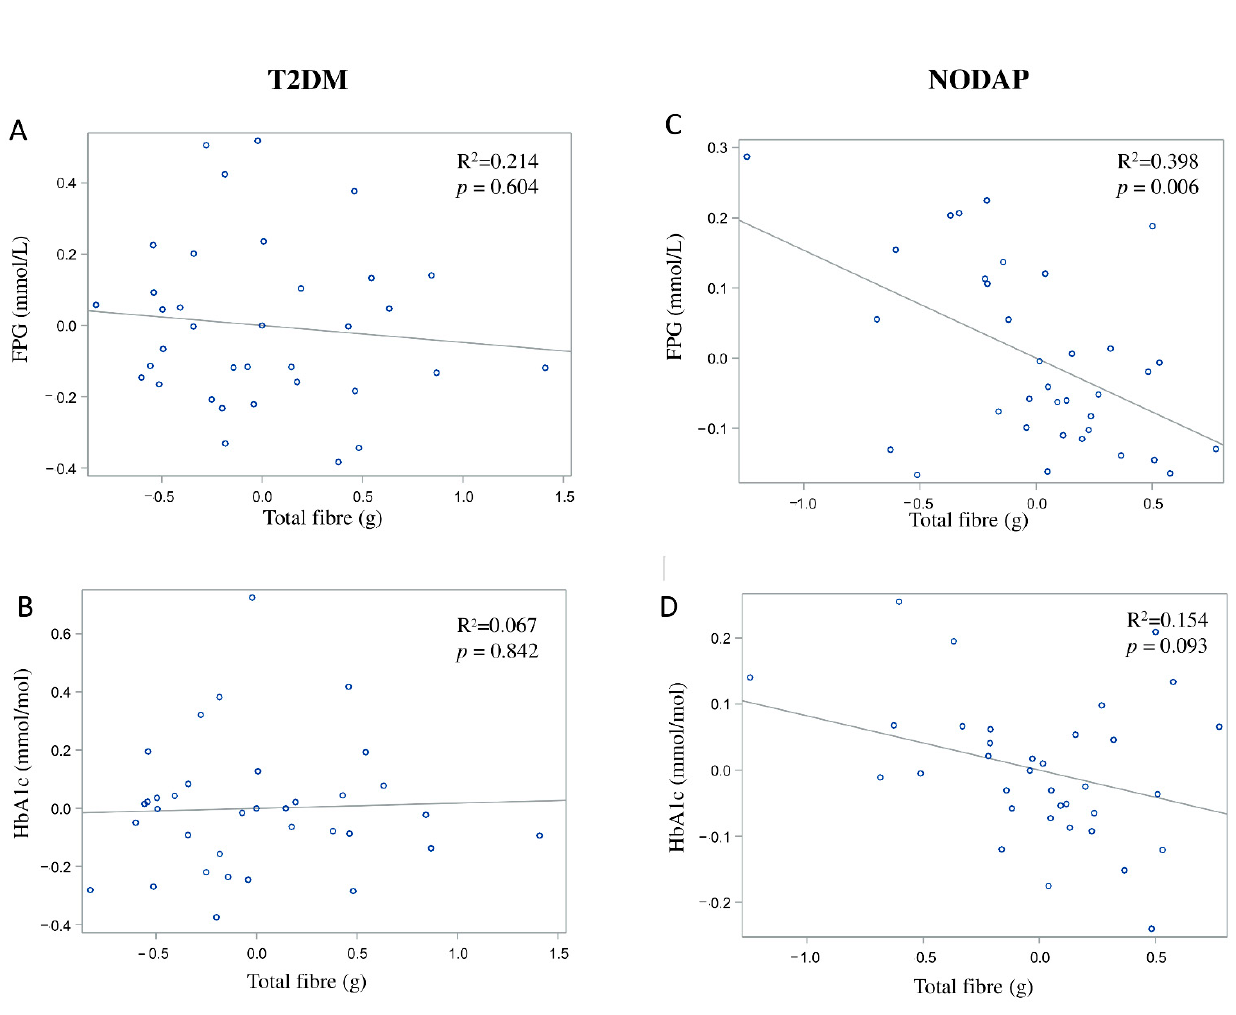
Figure 1. Associations between total fibre intake and markers of glucose metabolism in T2DM ( A , B ) and NODAP ( C , D ). Abbreviations: T2DM = Type 2 diabetes or prediabetes prior to acute pancreatitis. NODAP = New-onset diabetes or prediabetes after acute pancreatitis. HbA1c = glycated haemoglobin. FPG = fasting plasma glucose. R 2 = adjusted R 2 value (coefficient determinations). Footnotes: FPG, HbA1c, and total fibre data were log-transformed. R 2 values were adjusted for age, sex, BMI, energy intake (log-transformed), use of anti-diabetic medications, aetiology of pancreatitis, recurrence of pancreatitis, and presence of pancreatic necrosis.